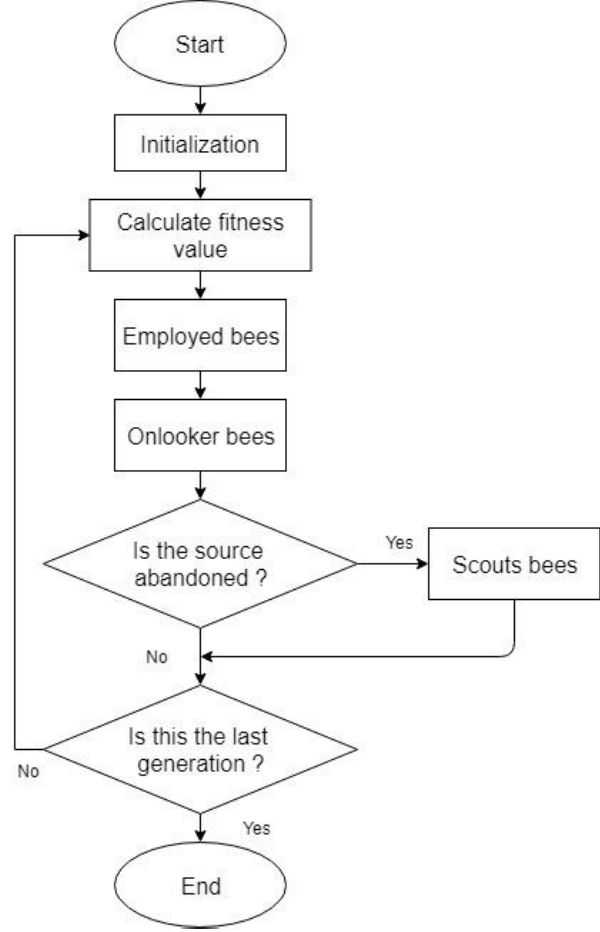
Figure 9. Flowchart of traditional Artificial Bee Colony (ABC) algorithm.